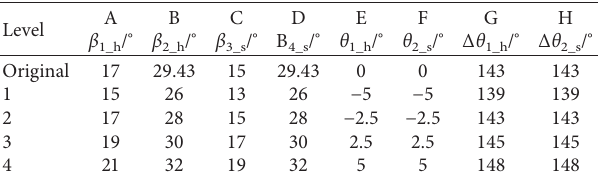
Table 3: Range of decision